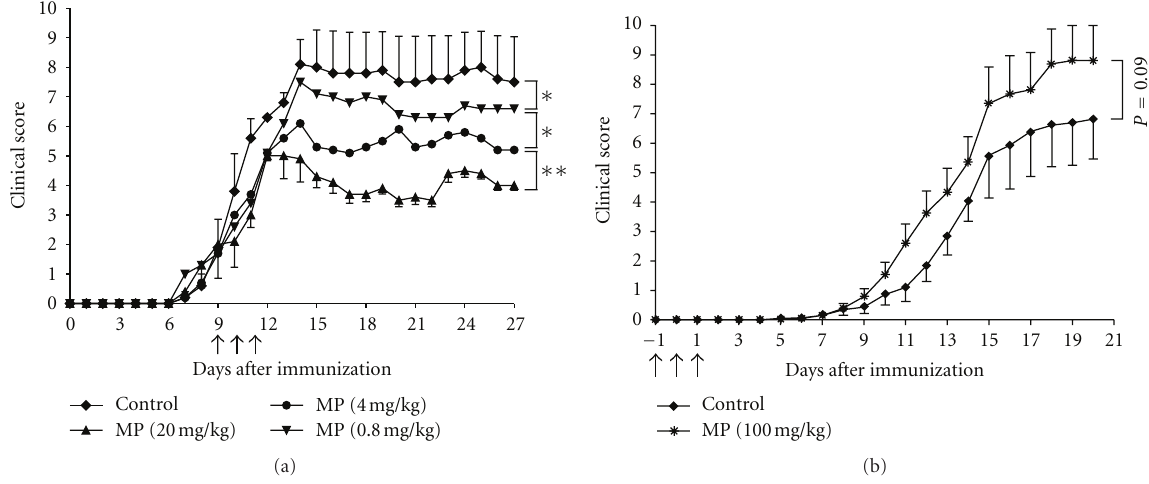
Figure 1: MP ameliorates EAE when applied in a therapeutic setting but aggravates it in a preventive setting. (a) EAE was induced in C57Bl/6 mice by immunization with MOG 35-55 and treated with di ff erent doses of MP for three consecutive days starting at an average score of 2-3 (marked by arrows). n = 5 for each group. All values are depicted as mean ± SEM; error bars for the two intermediate dose groups are omitted for reasons of clarity. Statistical analysis: days 10–27 after immunization ( ∗ P < 0 . 05, ∗∗ P < 0 . 01). (b) In a preventive setting, 100mg/kg MP was administered to C57Bl/6 mice on days − 1, 0, and +1 of immunization (marked by arrows). n = 8 for each group. All values are depicted as mean ± SEM. Statistical analysis: days